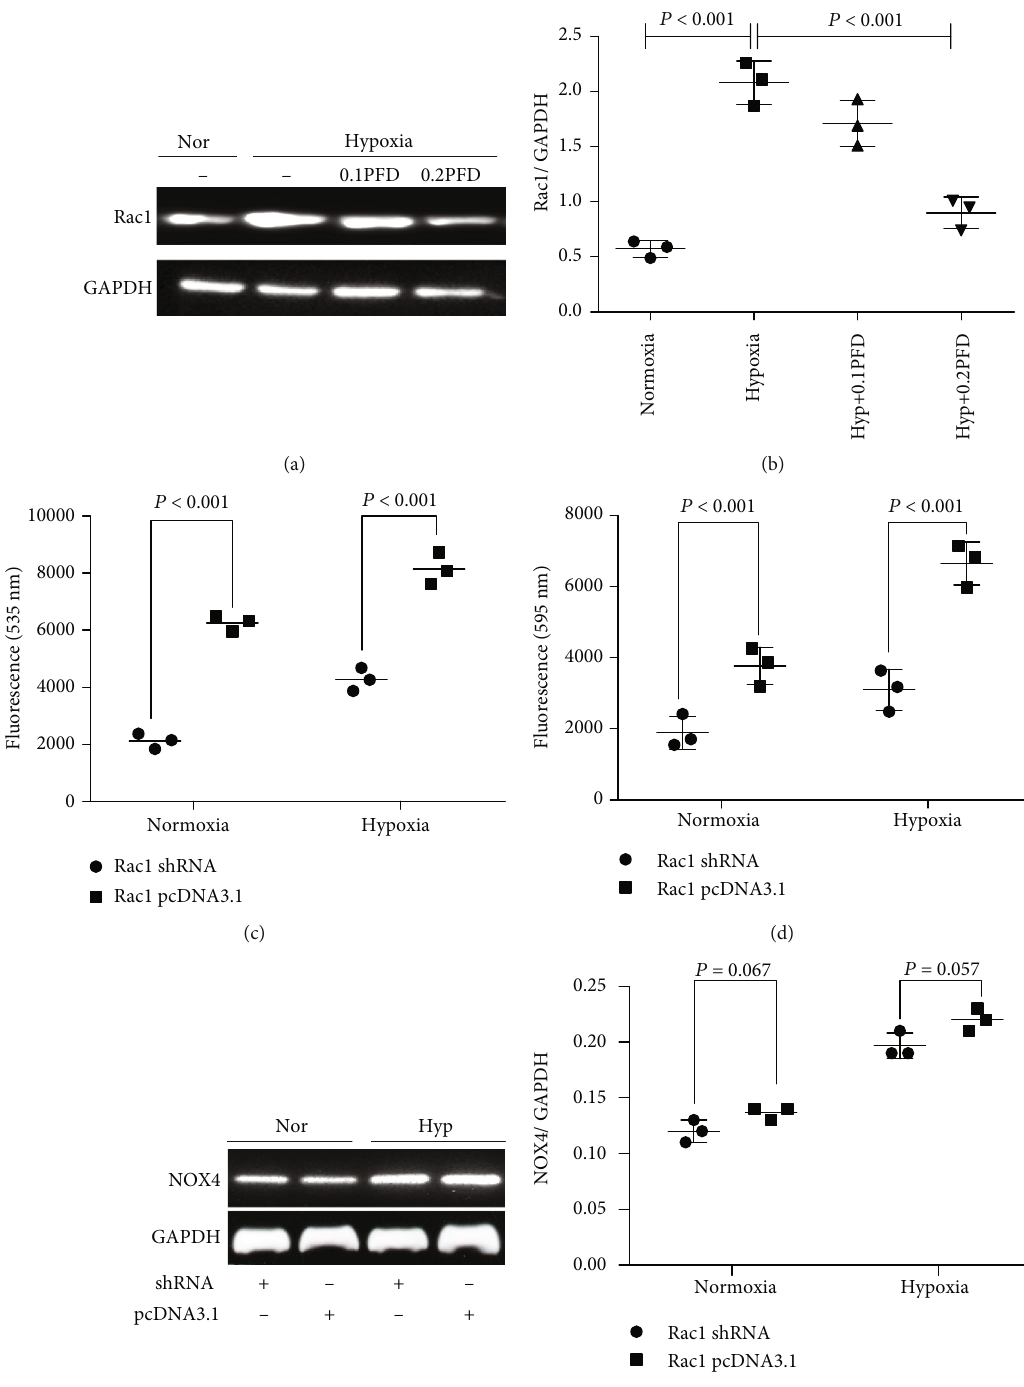
Figure 6: PFD treatment reduced the expression of Rac1, and inhibition of Rac1 reduced ROS without e ff ect on NOX4 in HPAAFs exposed to hypoxia. (a, b) Compared with the control, hypoxia increased Rac1 expression, while PFD treatment reduced the expression of Rac1 in HPAAFs ( n = 3 ). (c, d) Inhibition of Rac1 reduced ROS expression and overexpression of Rac1 increased ROS expression (e, f) with no e ff ect on NOX4 expression ( n = 3 ). PFD: pirfenidone; Nor: normoxia; Hyp: hypoxia; PFD: pirfenidone; HPAAFs: human pulmonary arterial adventitial fi